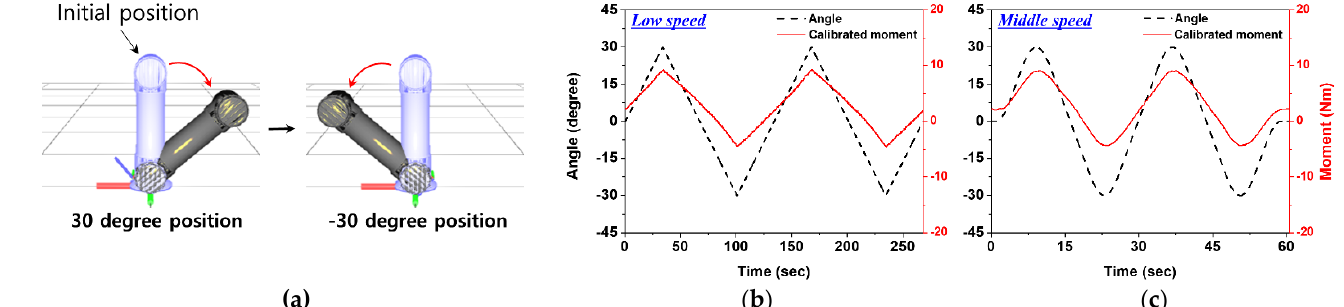
Figure 12. Evaluation of sensor’s external force detection performance according to the link’s slope change speed: ( a ) range of slope change of link; ( b ) the comparison result of link angle value and sensor data at low speed (0.89 degrees/sec); ( c ) the comparison result of link angle value and sensor data at middle speed (3.96 degrees/sec).